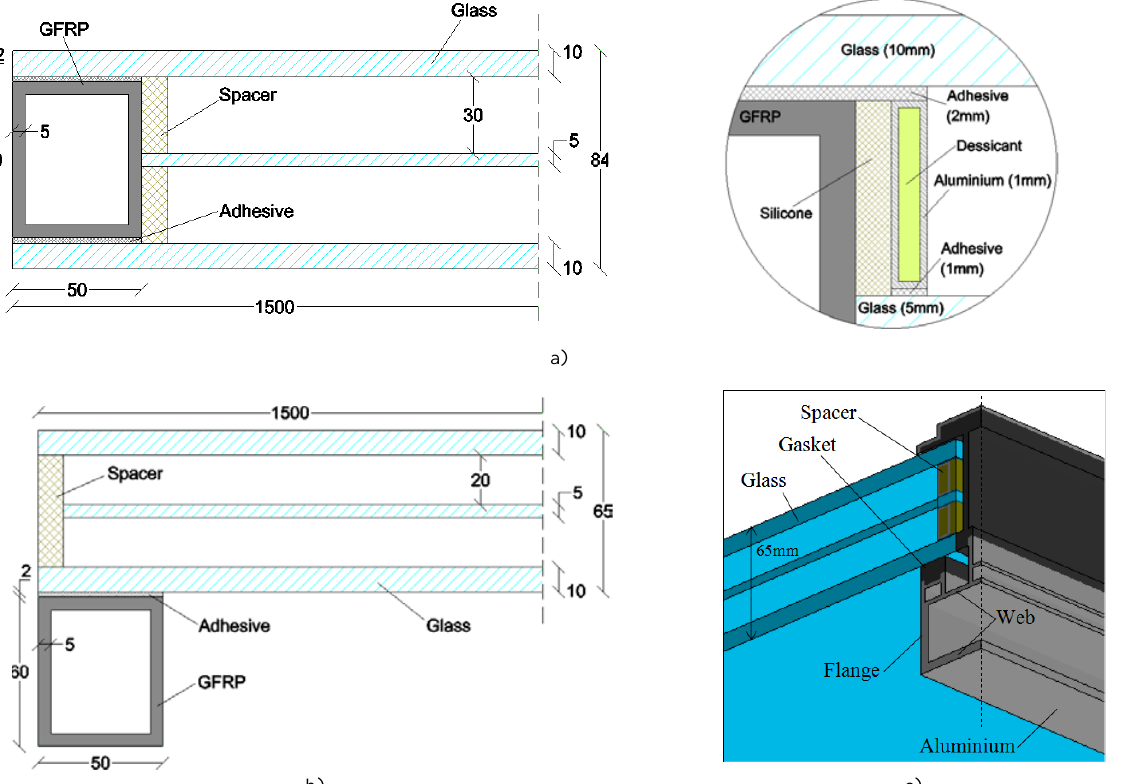
Fig. 3 Sandwich configurations of a) frame-integrated GFRP-glass sandwich panel with detailed view of spacer, b) non-integrated GFRP-glass panel and c) reference non-integrated aluminium-glass panel (all dimensions in